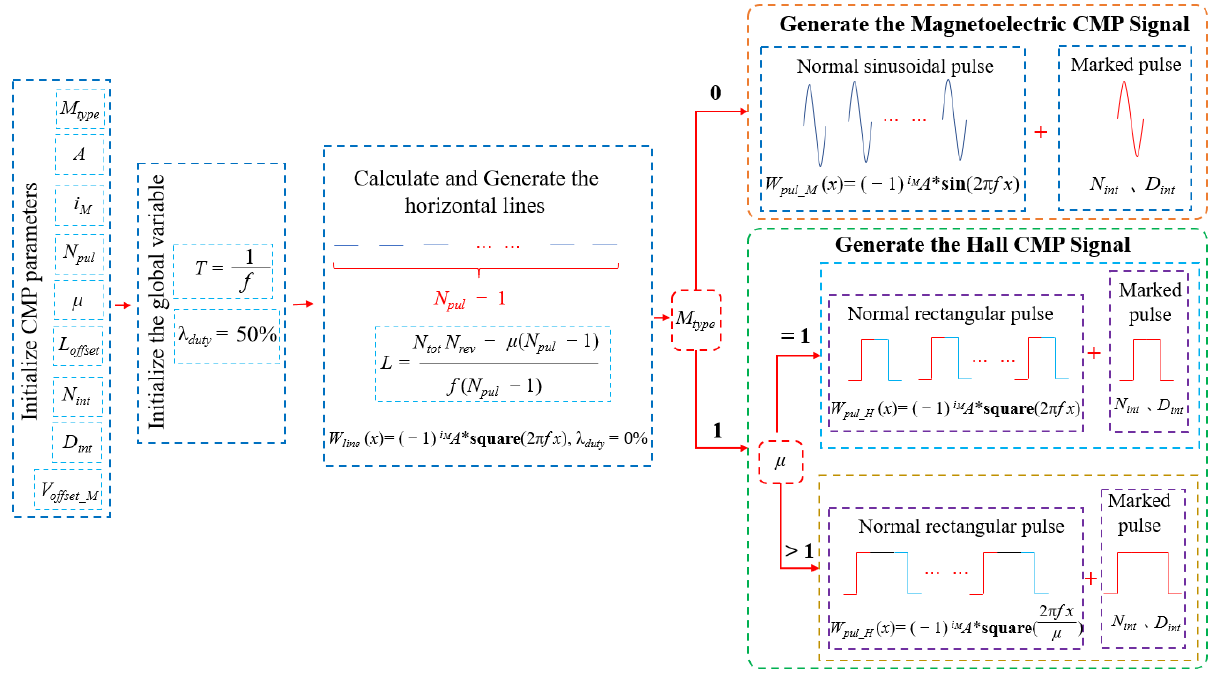
Figure 7. The CMP signal modeling process. L represents the length of a single horizontal line signal. µ represents the period multiple of a single pulse